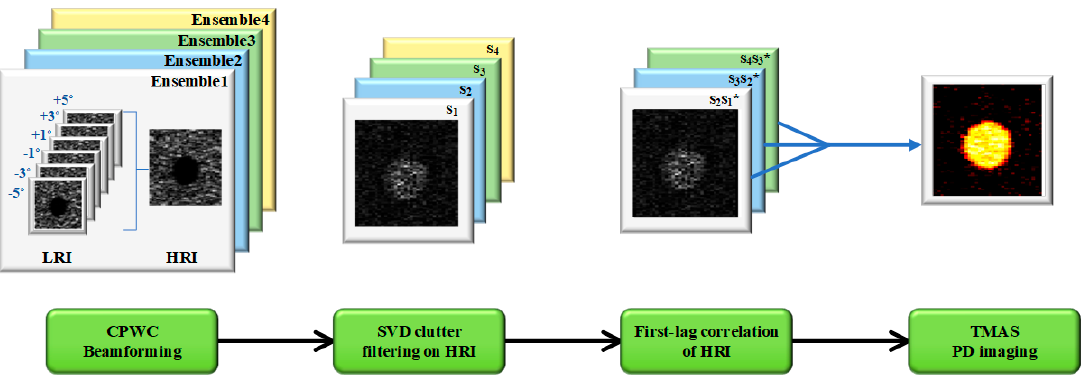
Figure 1. Schematic diagram of the proposed TMAS power Doppler detection in multi-angle PW imaging. Note that the correlation can be changed from first-lag to other higher-lag according to the flow velocity of interest. The symbol * represents complex conjugate.